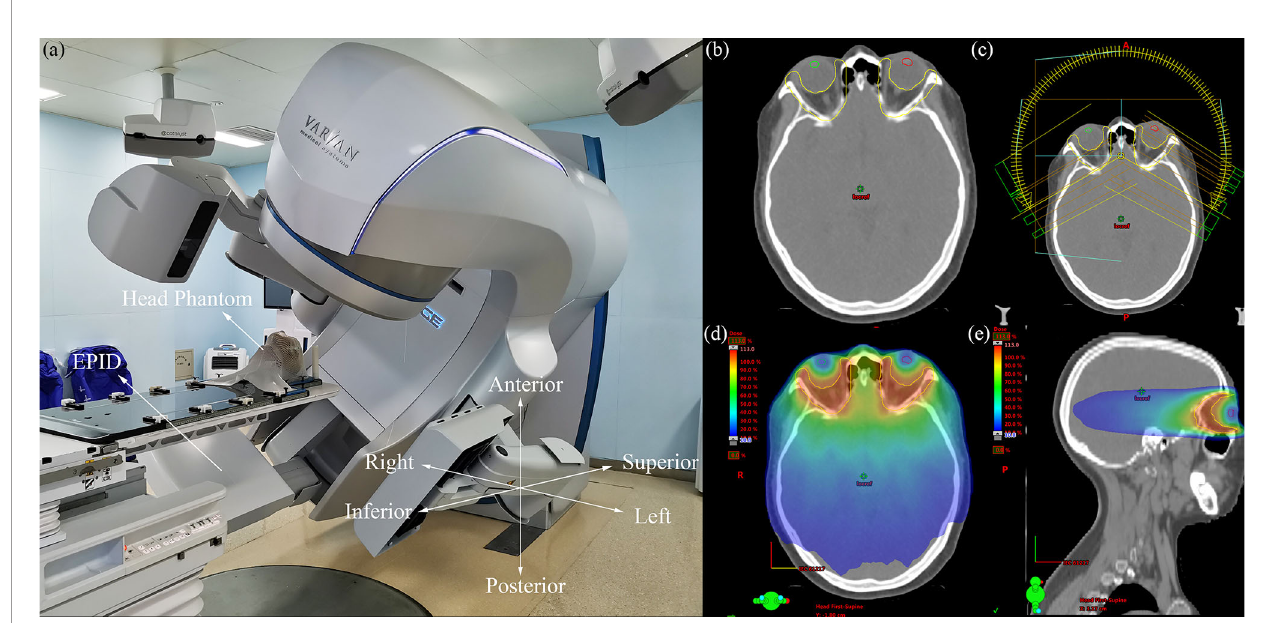
FIGURE 1 | (A) Photograph of the measurement process, the coordinate system in the lower right corner indicates the direction of the position errors, (B) transverse plane of one GO patient, the yellow region of interest (ROI) is PTV, the green and red ROI are lens, (C) VMAT plan with two partial arcs rotating from 240 to 120° clockwise and from 120 to 240° counterclockwise, (D) the dose distribution of transverse plane, (E) the dose distribution of sagittal plane.